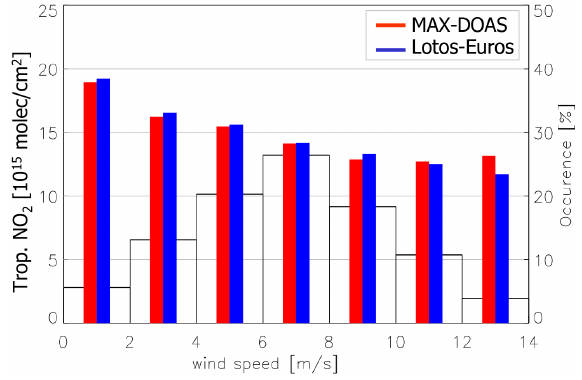
Figure 14. Average tropospheric NO 2 column as a function of wind speed. Values above 12ms − 1 are not shown because of the low number of data for this